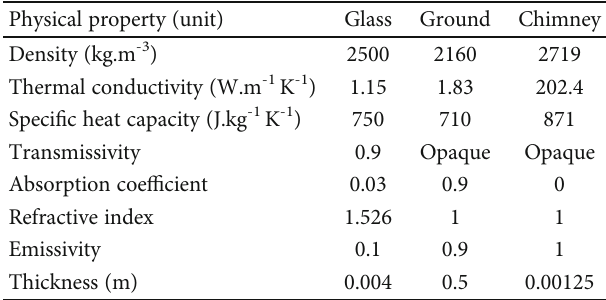
Figure 1: SCPP with sloping ground and corresponding boundary conditions. Table 2: Physical properties of the materials used in the CFD research [8].